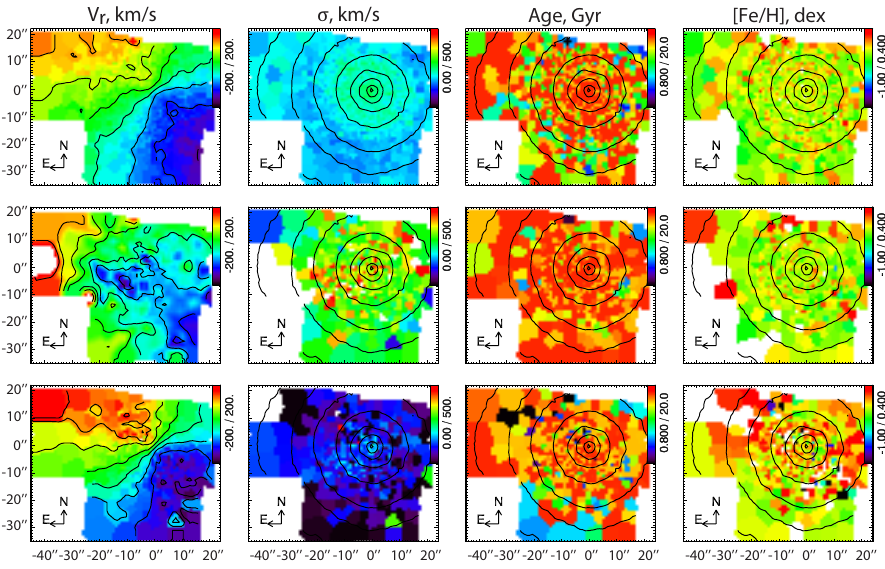
Fig. 4. SAURON integral-field spectroscopic data. From left to right: velocity, ve- locity dispersion, SSP-equvalent ages and metallicities. First row correspond to one- component fitting spectra. Second and third rows present the ’bulge’ and ’disk’ parameter maps for two-component spectra